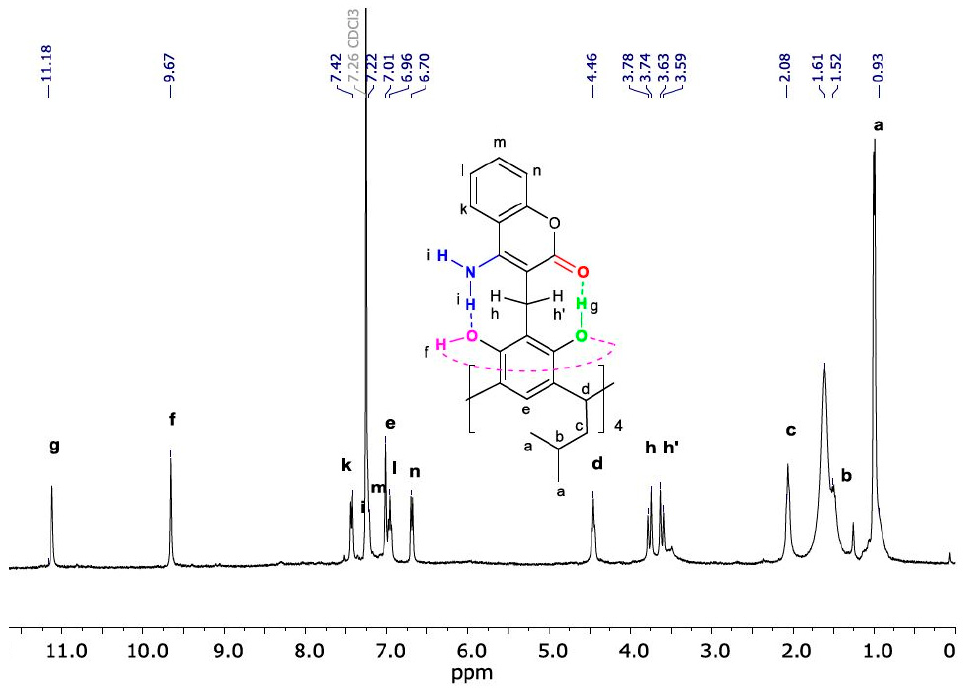
Figure 1. The 1 H NMR spectrum (400 MHz) of derivative 3 in CDCl 3 at 298 K.